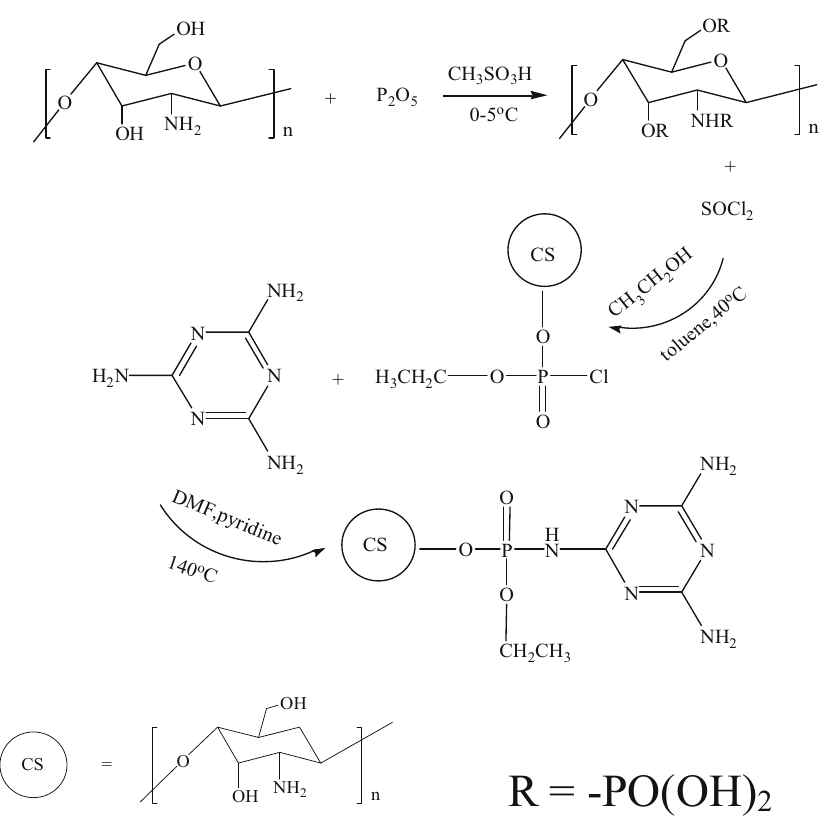
Scheme 1: Synthetic route of chitosan ethoxyl melamine phosphate ( CEMP )